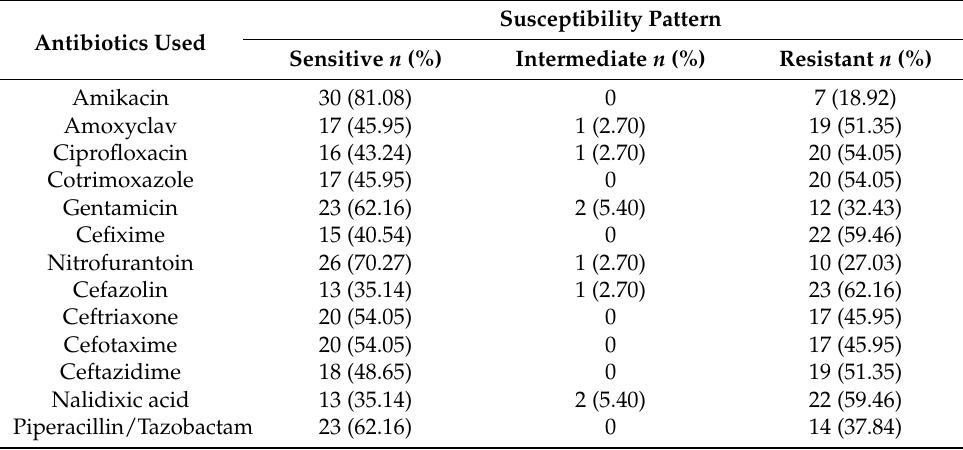
Table 4. Antibiotic susceptibility pattern of E. coli .